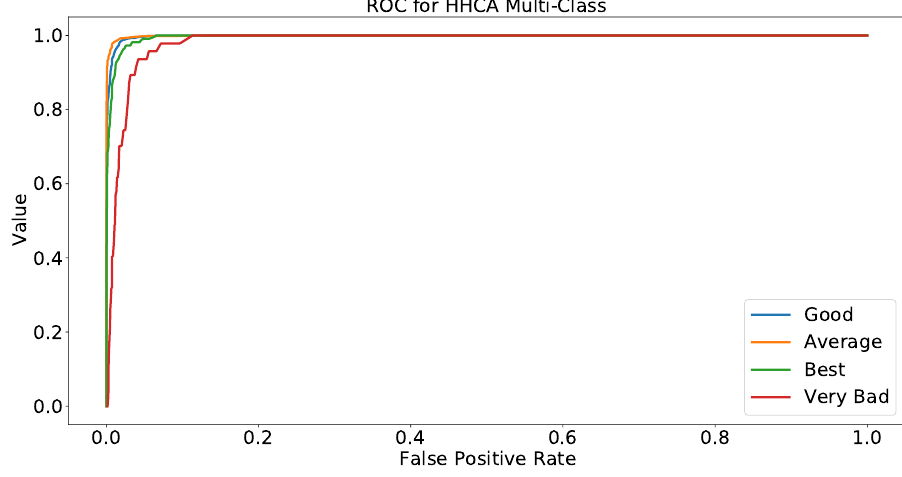
Figure 3. ROC for HHCA multi-class